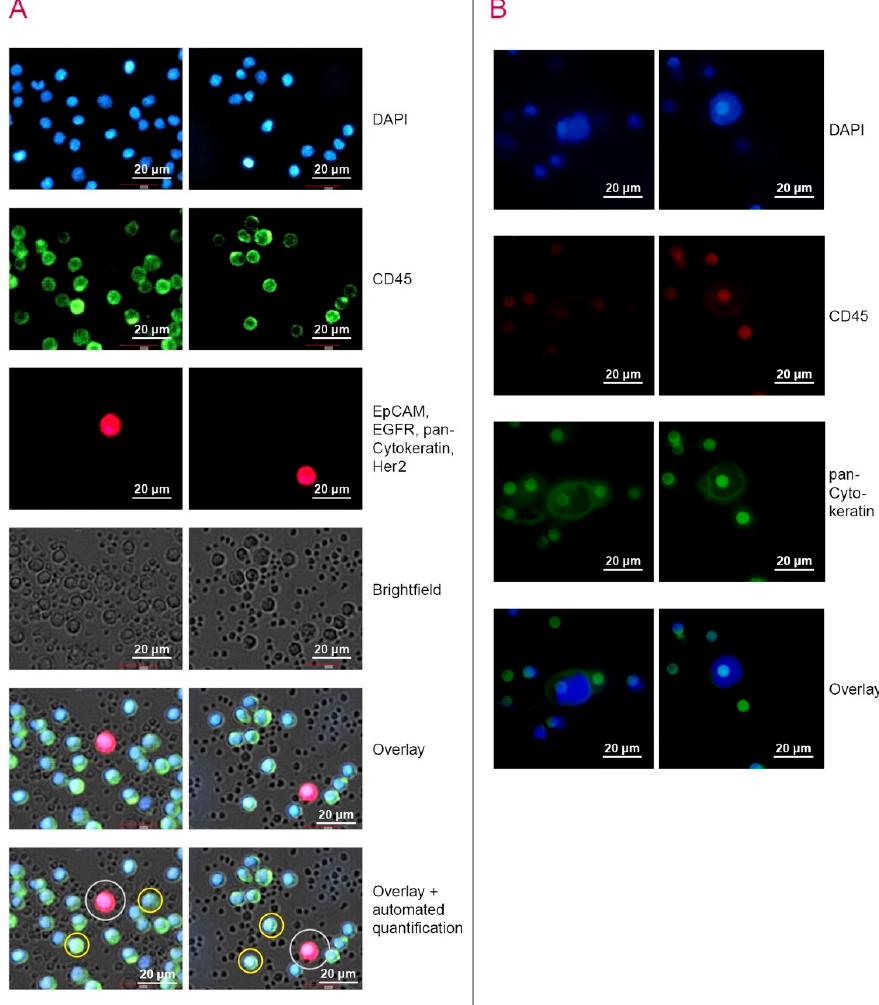
Figure 2. CTC detection in patient samples using NYONE ® and ScreenCell ® technology. CTC in peripheral patients´ blood samples were enriched by CPT vacutainer tubes for NYONE ® analysis, or by isolation by size via a porous membrane in the ScreenCell ® study cohort. Samples were then stained for CTC detection. ( A ) NYONE ® —CTC were stained with anti-EpCAM, anti-EGFR, anti-Her2 and anti-pan-CK antibodies (red), and leukocytes were stained with anti-CD45 antibodies (green). DAPI staining was performed for nuclei staining (blue). Cells were scanned by NYONE ® and quantified by YT ® -Software (here, CTC encircled in white and two exemplary CD45-positive cells in yellow) ( B ) ScreenCell ® —CTC were IF stained with anti-pan-CK antibodies (green), leucocytes IF stained with anti-CD45 antibodies (red)and DAPI staining was performed for nuclei staining (blue).